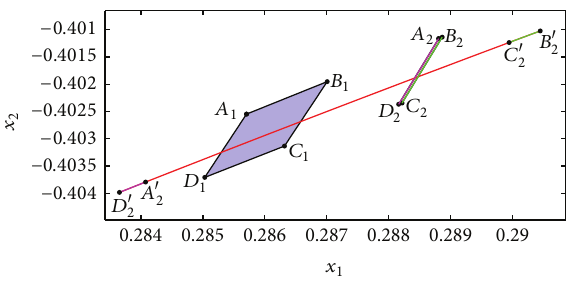
Figure 8: The image 𝜋(|𝐴 2 𝐵 2 𝐶 2 𝐷 2 |) lies wholly across |𝐴 1 𝐵 1 𝐶 1 𝐷 1 | and |𝐴 2 𝐵 2 𝐶 2 𝐷 2 | .